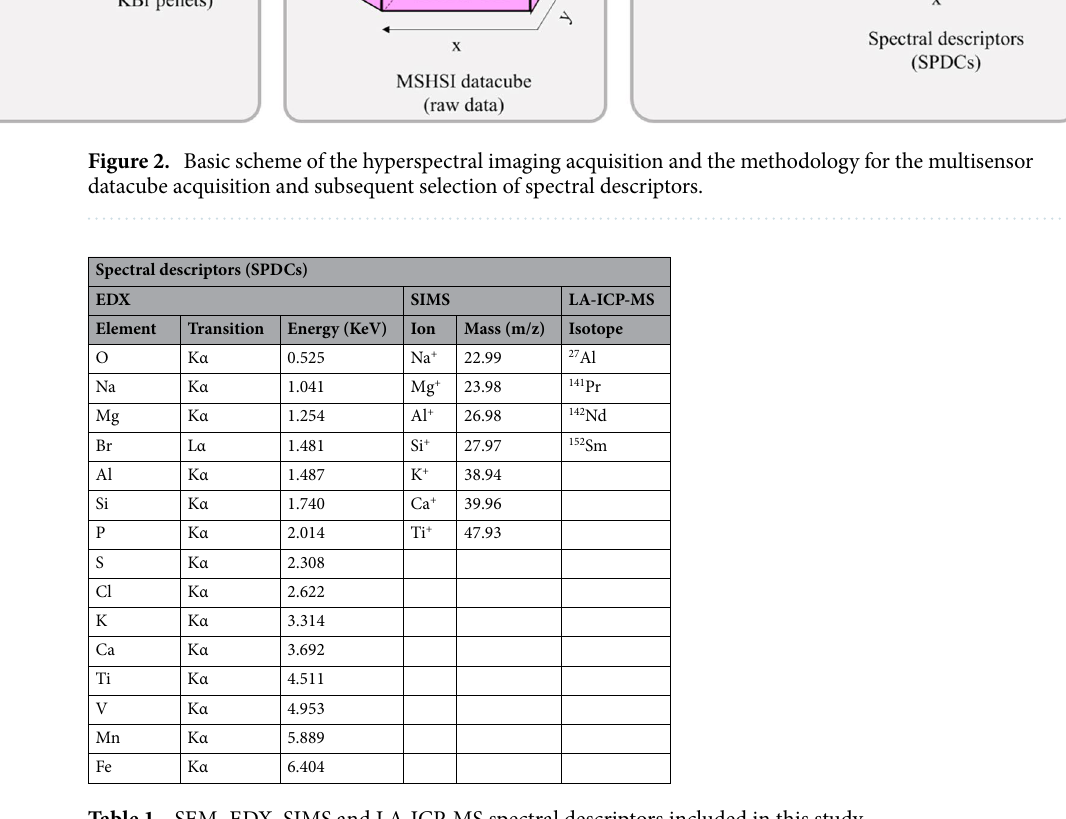
Table 1. SEM–EDX, SIMS and LA-ICP-MS spectral descriptors included in this